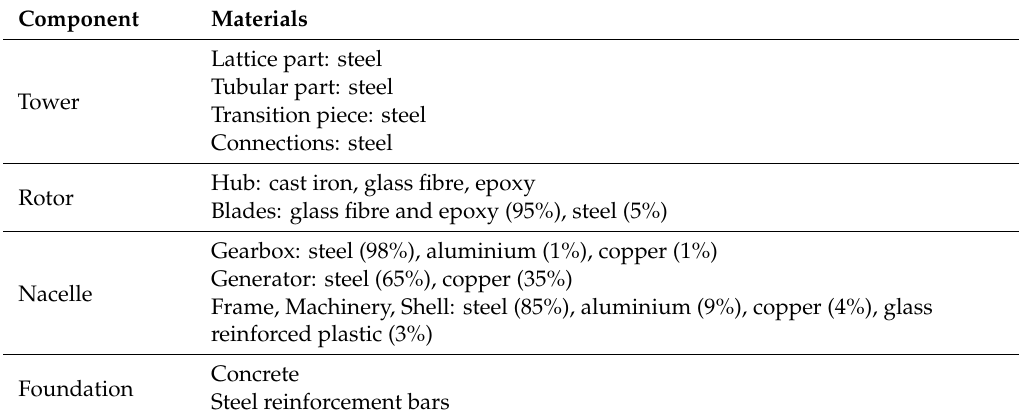
Table 2. Components and materials of a wind turbine